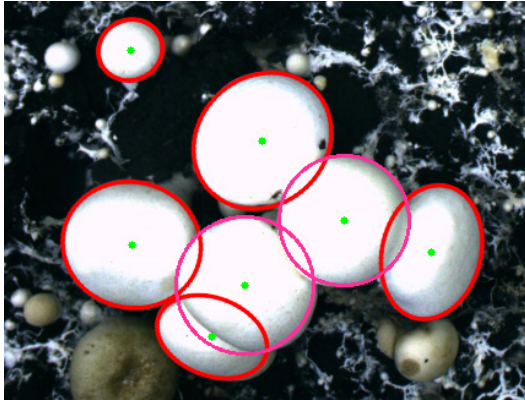
Figure 16. Recognition effect of Agaricus bisporus .